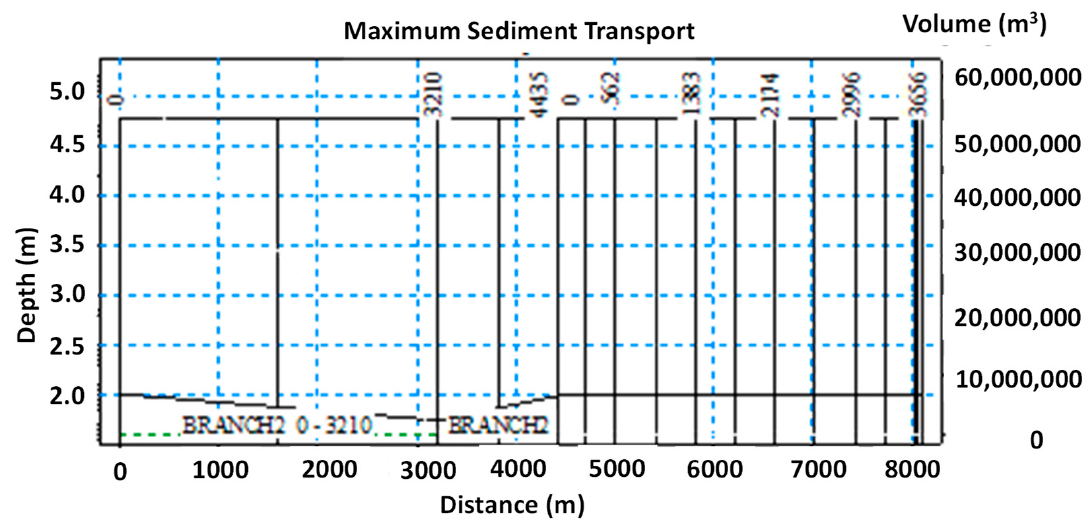
Figure 8. Sediment movement in MDC without sluicegate.